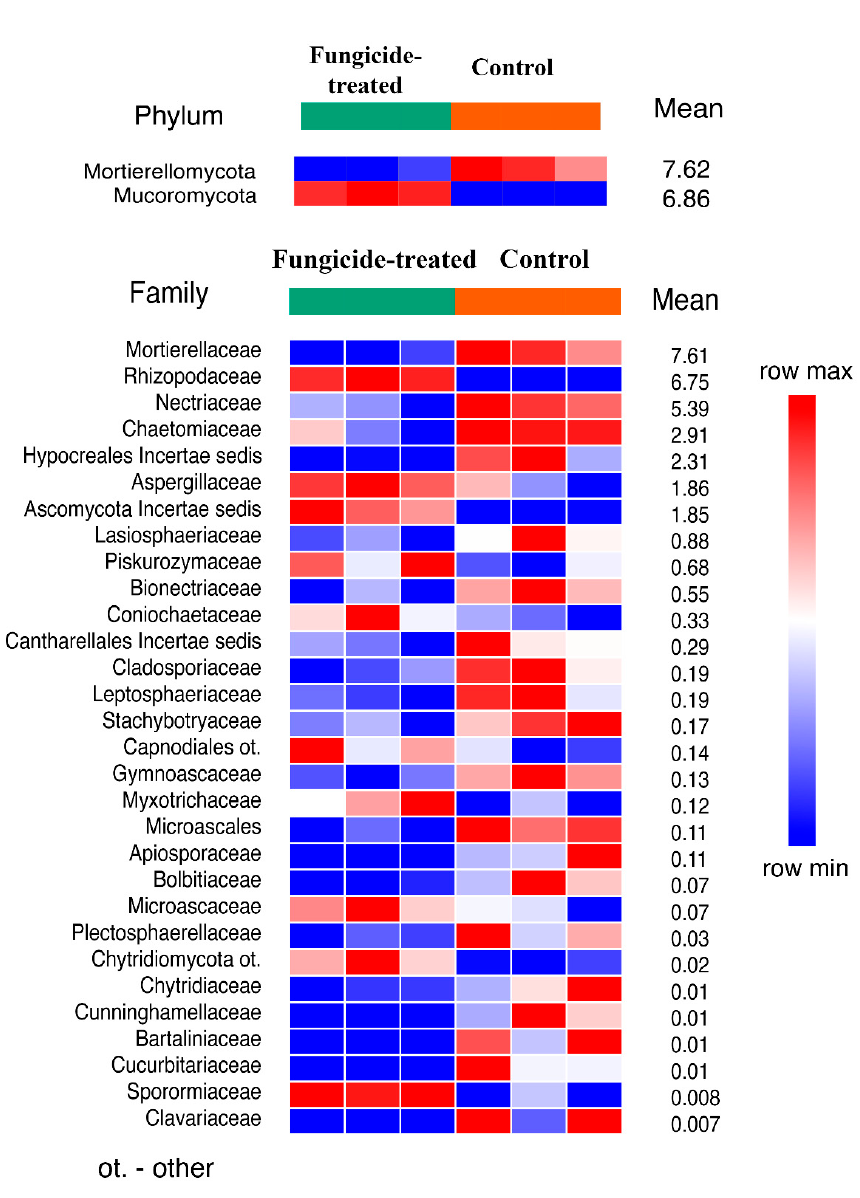
Figure 6. Heatmap of the relative abundance of fungal genera, estimated on the basis of ASV reads.